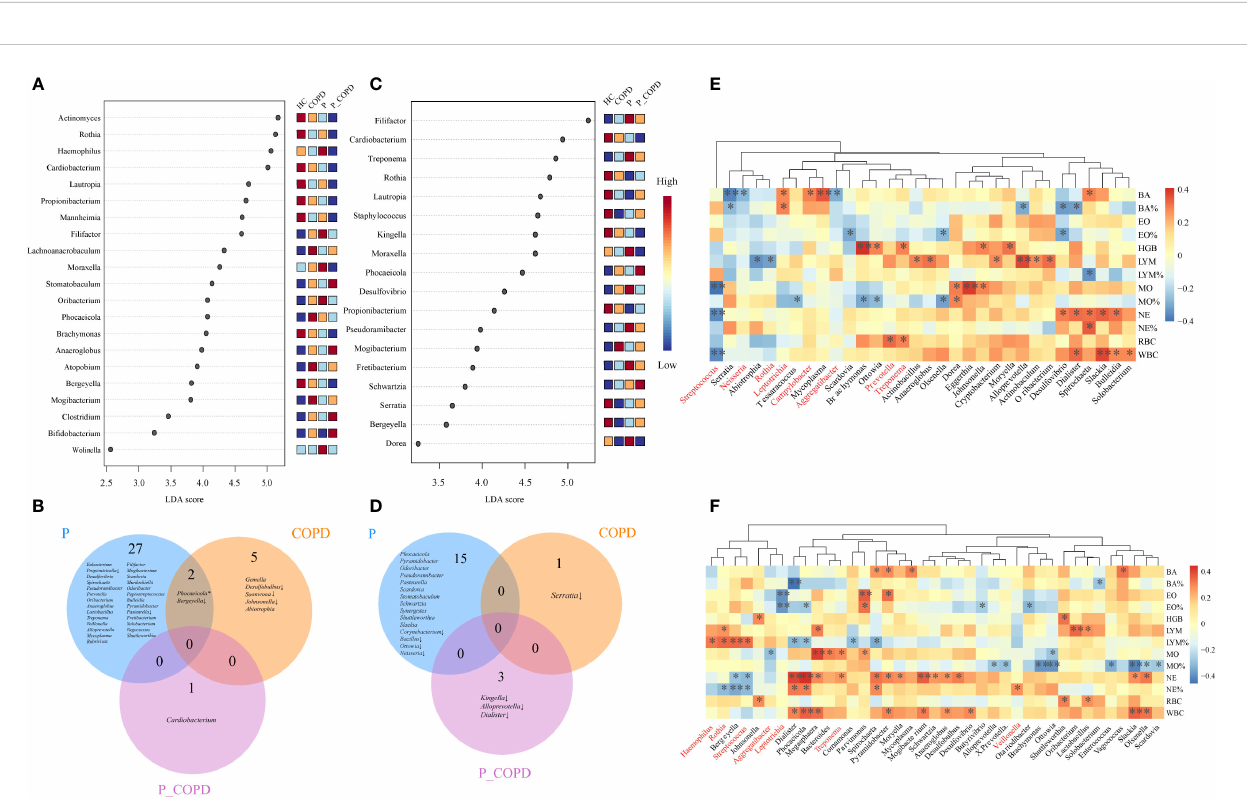
FIGURE 3 Linear discriminant analysis of effect size (LEfSe) of oral microbiota at the genus level enriched in healthy controls (HC), periodontitis (P) group, chronic obstructive pulmonary disease (COPD) group and comorbid diseases (P_COPD) group. LDA score (log10) <2, P < 0.05) (A) In subgingival plaque samples. (C) In gingival crevicular fl uid samples. DESeq2 analysis of oral microbiota. Oral microbiota with signi fi cantly difference from the diseased groups compared with healthy controls (B) in subgingival plaque samples, (D) in gingival crevicular fl uid samples. * The relative abundances of Phocaeicola was more abundant in CP group, while the relative abundance of Phocaeicola in COPD group was lower than HC groups. ↓ , decreased. Spearman ’ s coef fi cient calculated between oral microbiota and clinical indicators. The taxa analyzed were the top 20 genera in terms of abundance (E) in subgingival plaque samples, (F) in gingival crevicular fl uid samples. Black stars within heatmap boxes indicate signi fi cant results (*: P ≤ 0.05, **: P ≤ 0 .01), Benjamini – Hochberg adjustment for multiple